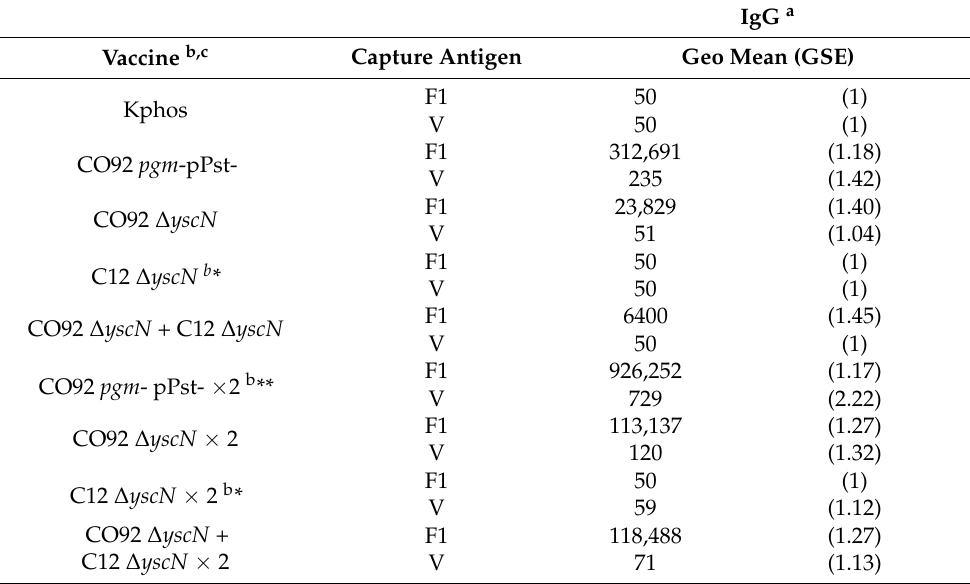
Table 7. Humoral responses to F1 and V antigens by Y. pestis vaccine